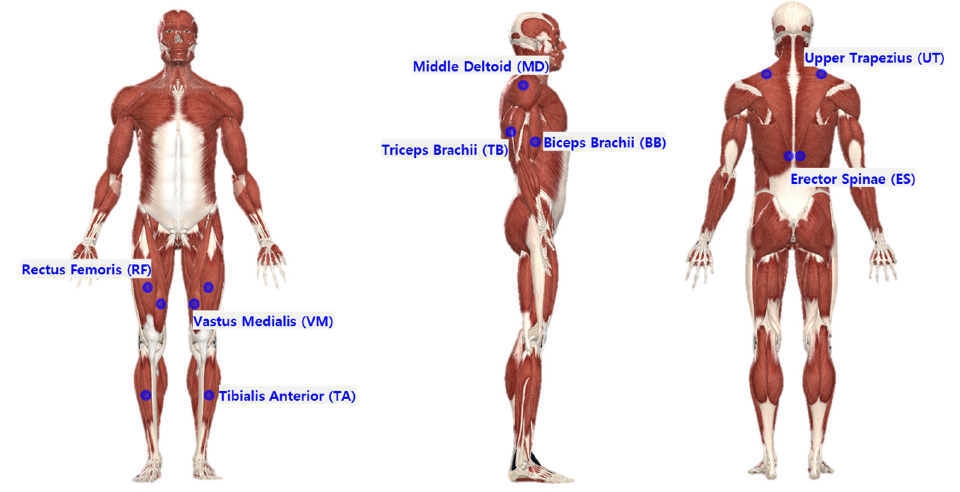
Figure 3. Locations of EMG sensor attachments.